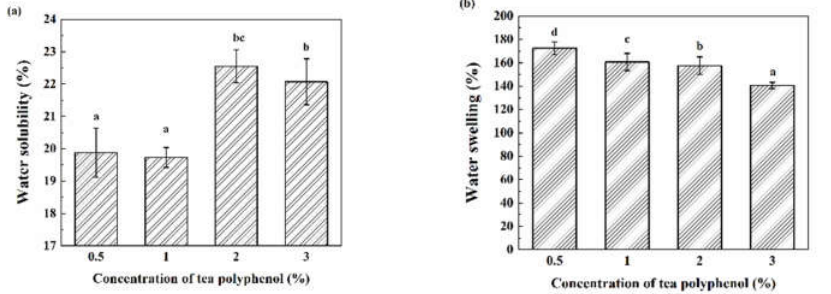
Figure 2. ( a ) Water solubility of CS/CH/TP films and ( b ) water swelling of CS/CH/TP films. Values